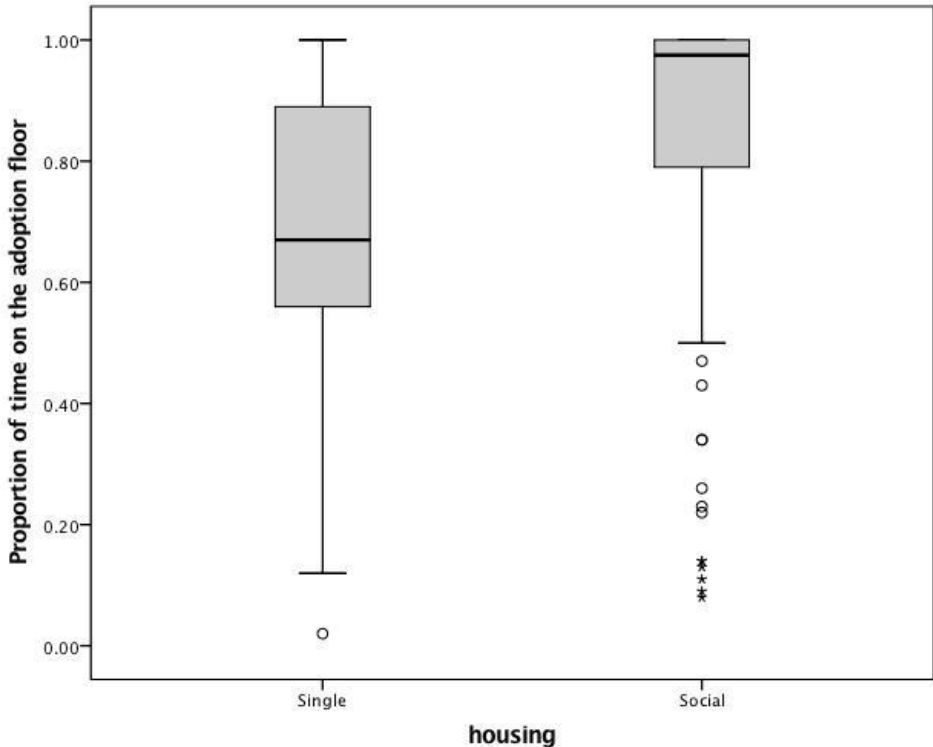
Figure 3. Single-housed cats spent significantly less time visible on the adoption floor than group- housed cats (W = 14,844.00, Z = 5.78, p < 0.001).